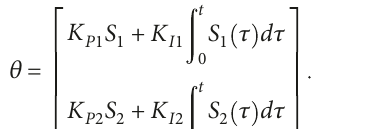
Figure 7: The simulation results of step response of steady state power management. (a) Low pressure rotor speed N Turbine outlet temperature versus time